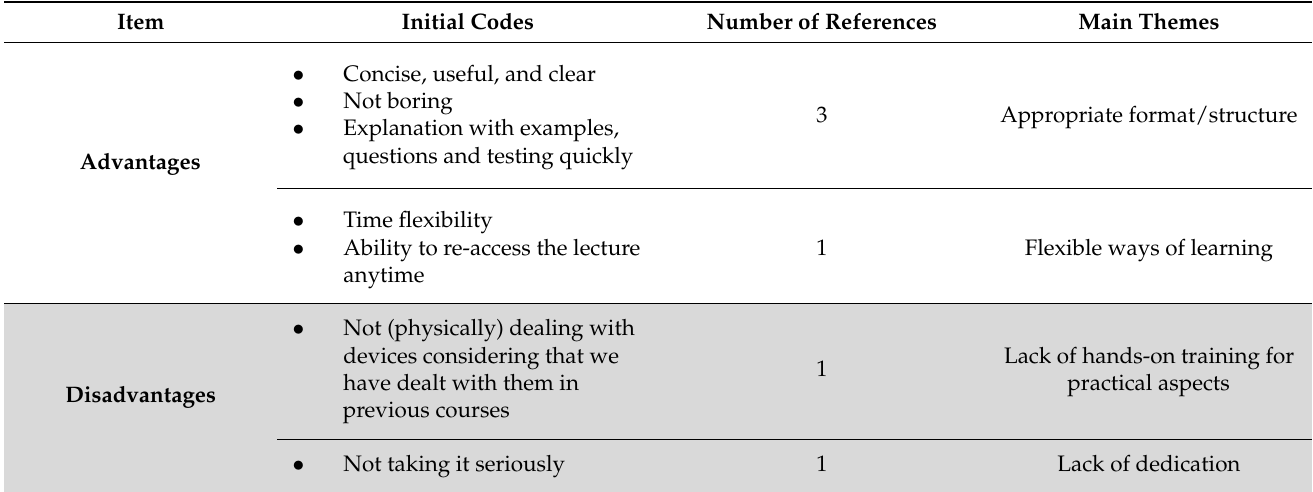
Table 7. Advantages and disadvantages of interactive flipped e-learning activity (iFEEL) from students’ points of view.